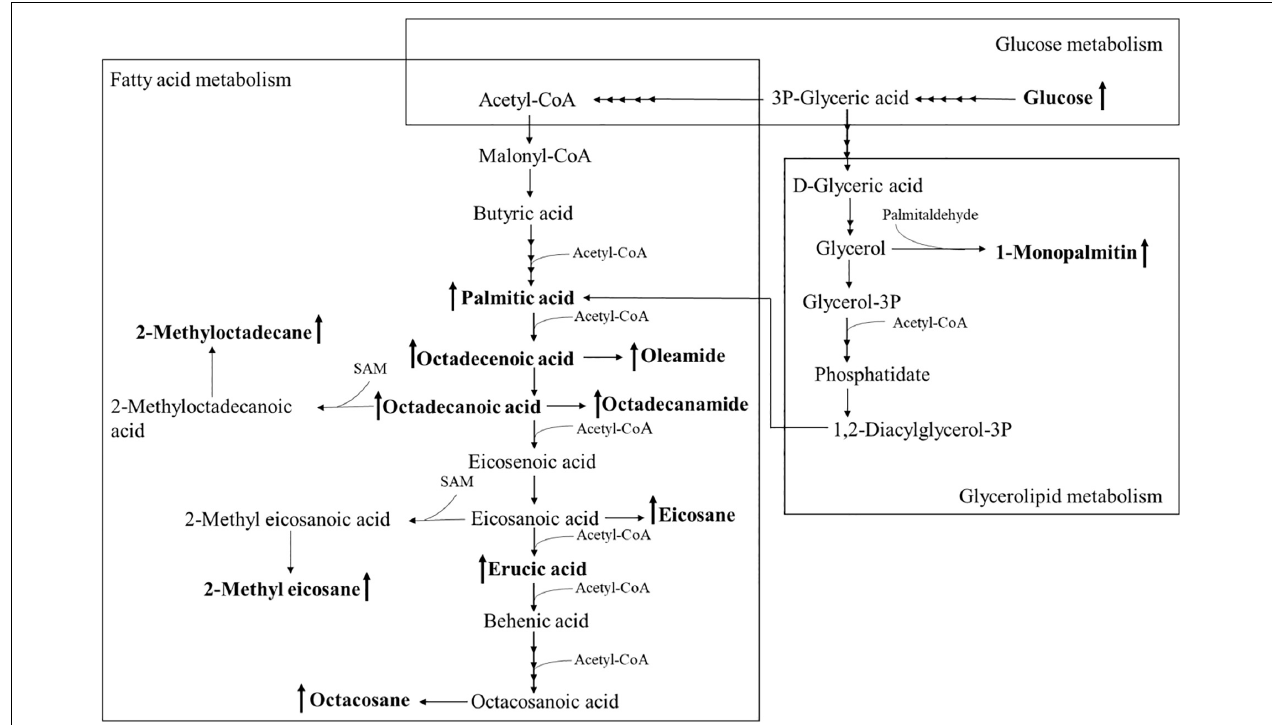
FIGURE 9 | Altered MTB metabolome induced by treatment with 8.0 µ g/ml DHA-CS NPs. The schematic representation indicates the 12 metabolite markers in bold, and increases in the metabolite markers are indicated by ↑ .